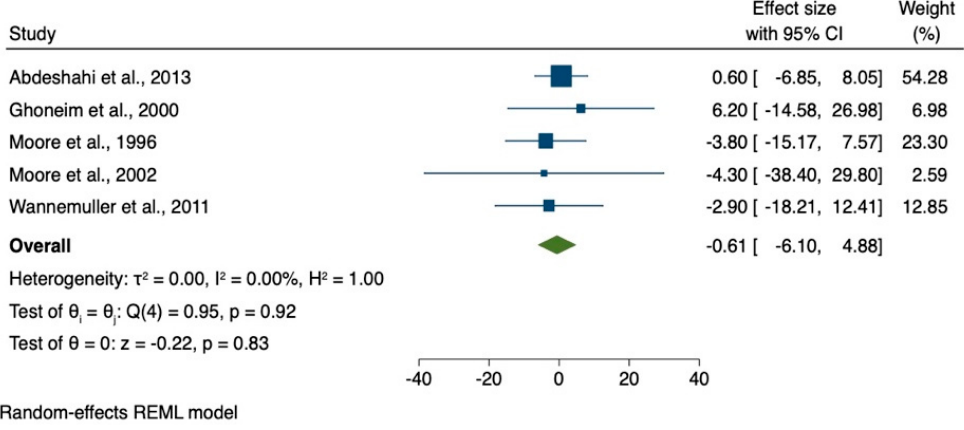
Figure 2. Meta-analysis of studies using State-Trait Anxiety Inventory (STAI).